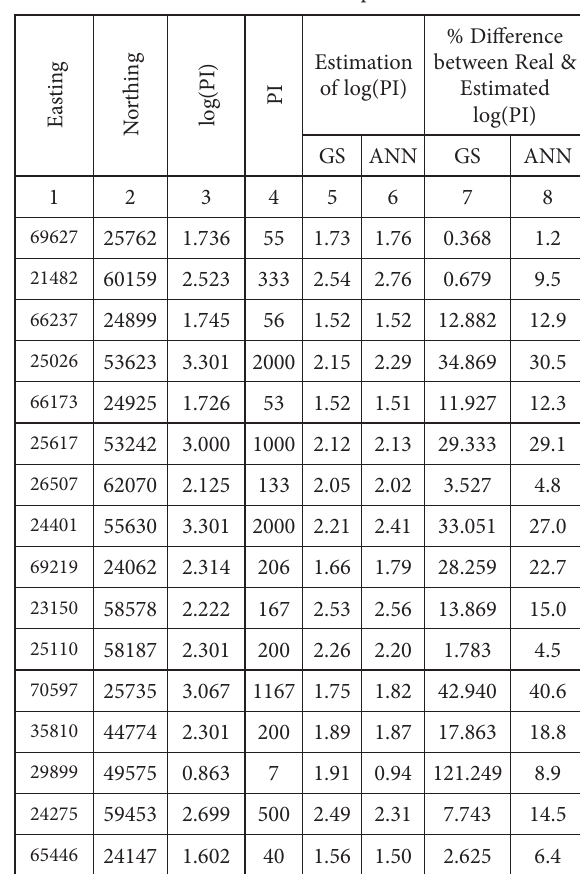
Table 1. Compare the two methods of geostatistical and ANN for estimation PI parameter